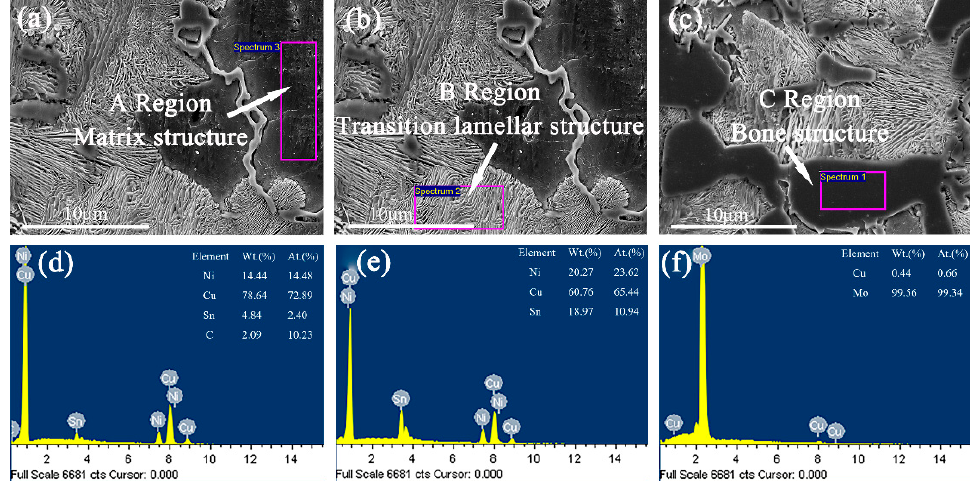
Figure 6. The SEM images of as-cast structure for Cu–15Ni–8Sn–0.9Mo alloy: ( a , d ) matrix structure, ( b , e ) transition lamellar structure, ( c , f ) bone structure.